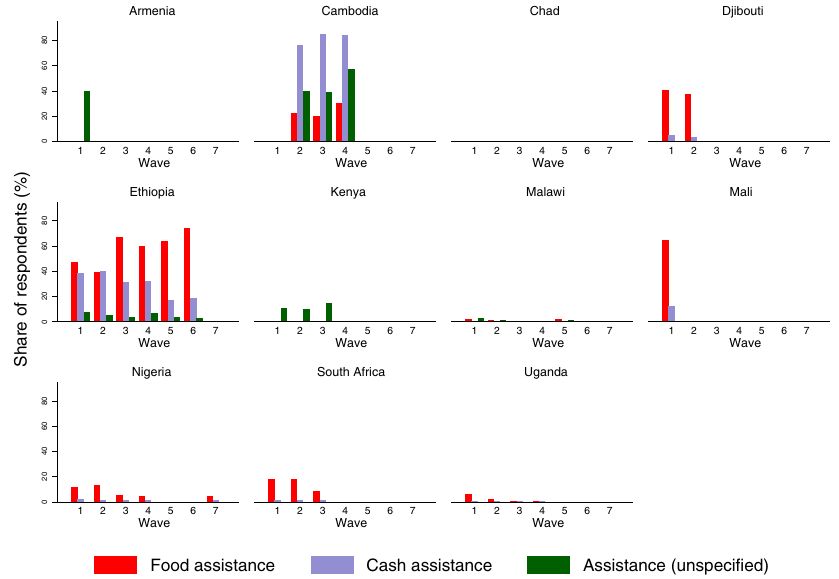
Figure 3. Tracking food insecurity and safety nets during the pandemic.